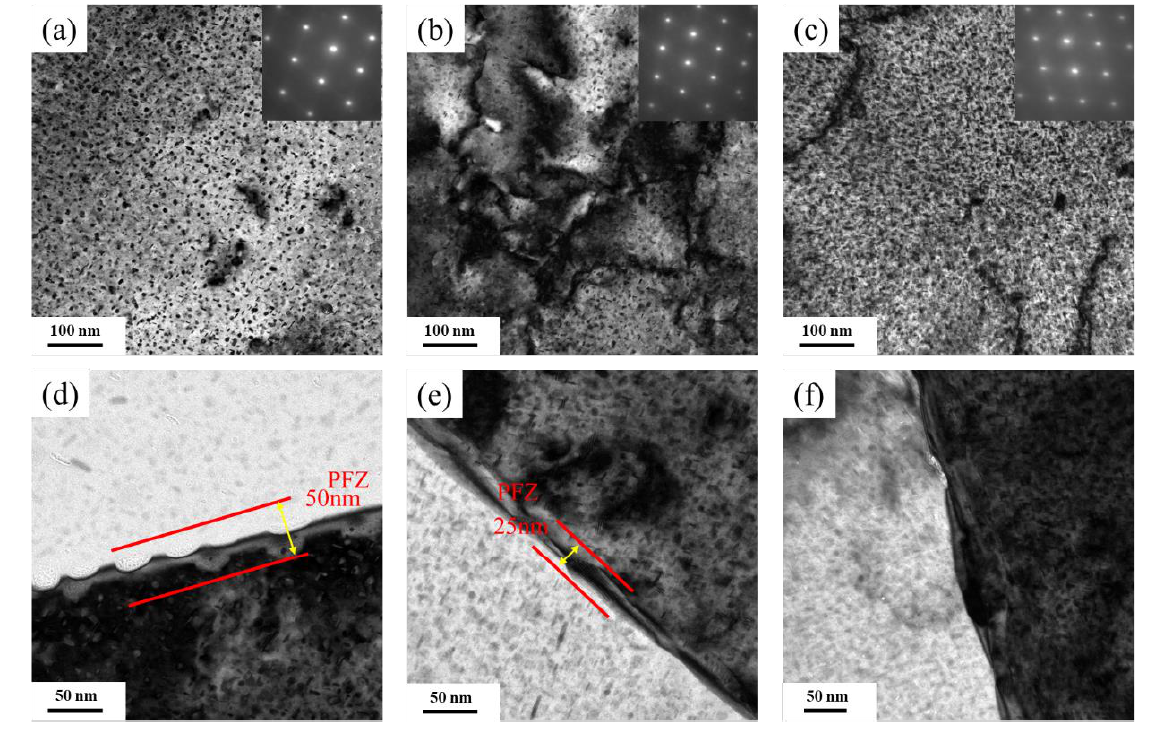
Figure 9. TEM images of the 7085 alloys after T6 heat treatment: ( a , d ) HTD; ( b , e ) MTD; ( c , f ) CTD.